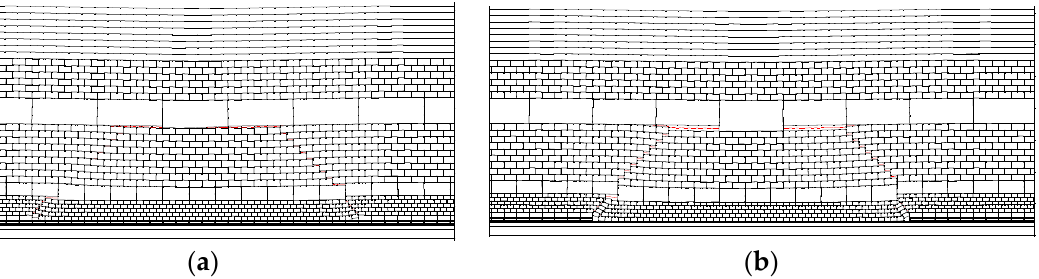
Figure 15. Strata movement and bed separation due to mining (red line denotes the bed separation): ( a ) mining height 4 m; ( b ) mining height 7 m